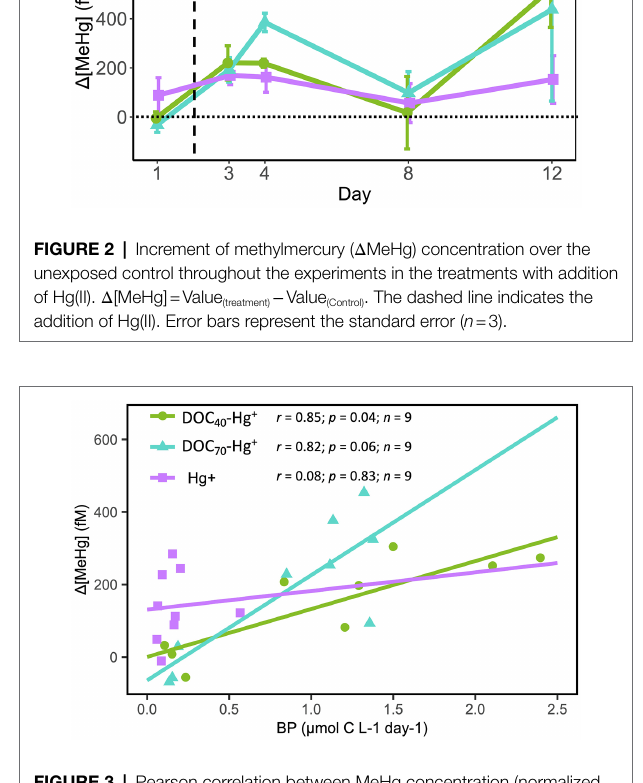
FIGURE 3 | Pearson correlation between MeHg concentration (normalized against control; Δ [MeHg]) and bacterial production (BP) over the first 4 days of the experiment in the DOM and Hg treatments. Pearson correlation coefficients ( r ), p -values ( p ) and number of observations ( n ) are